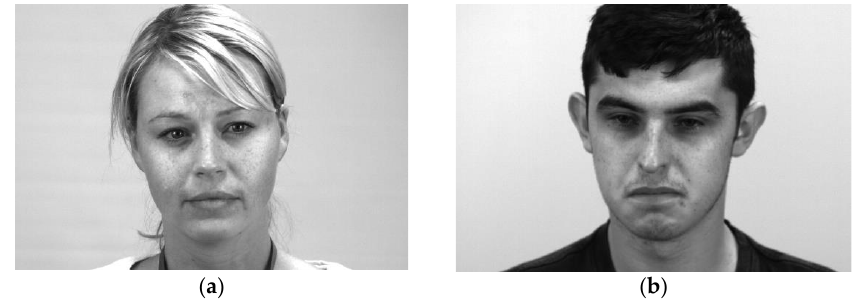
Figure 13. Correct recognition results on the SAMM dataset: ( a ) happy and ( b ) other.